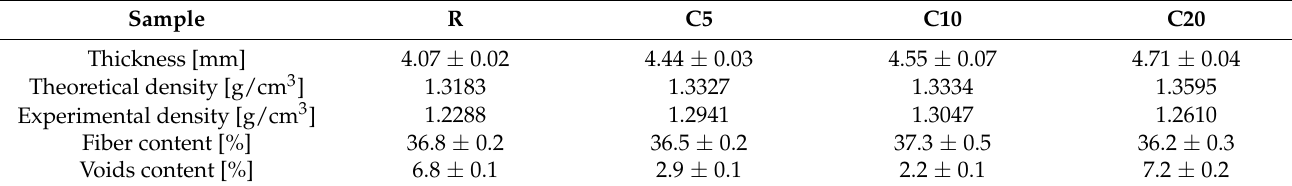
Table 2. Main physical properties of composites for each treatment